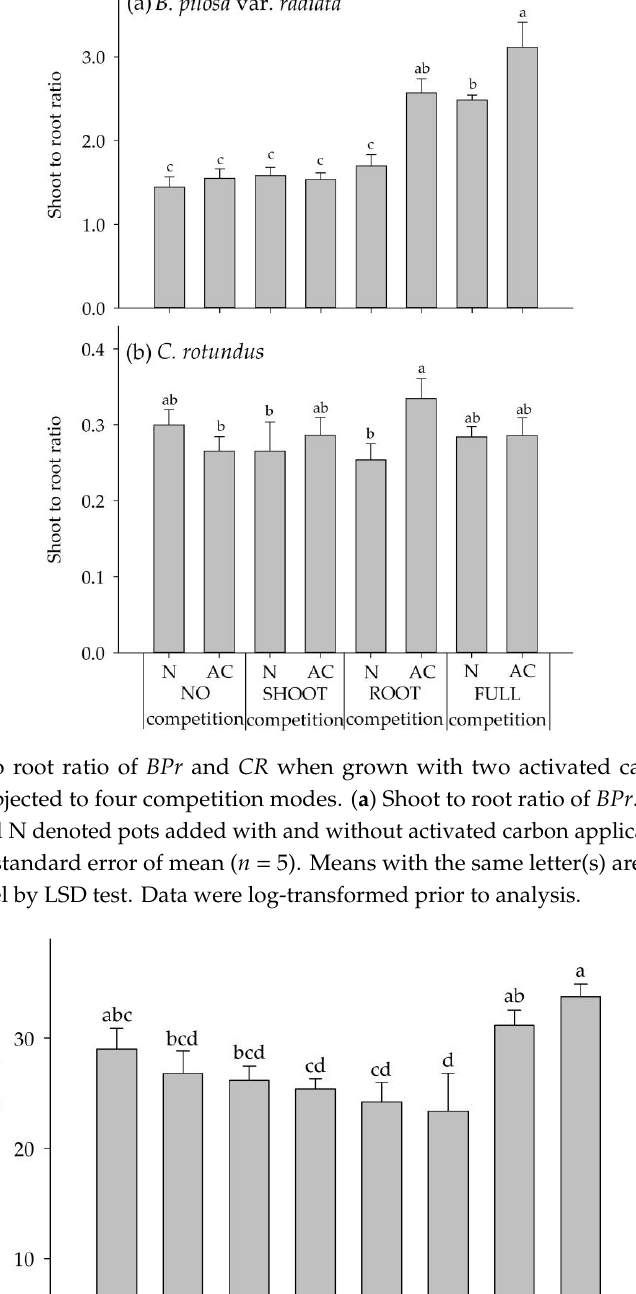
respectively. Error bars are the standard error of mean ( n = 5). Means with the same letter(s) are not significantly different at 5% level by LSD test. Data were log-transformed prior to analysis.